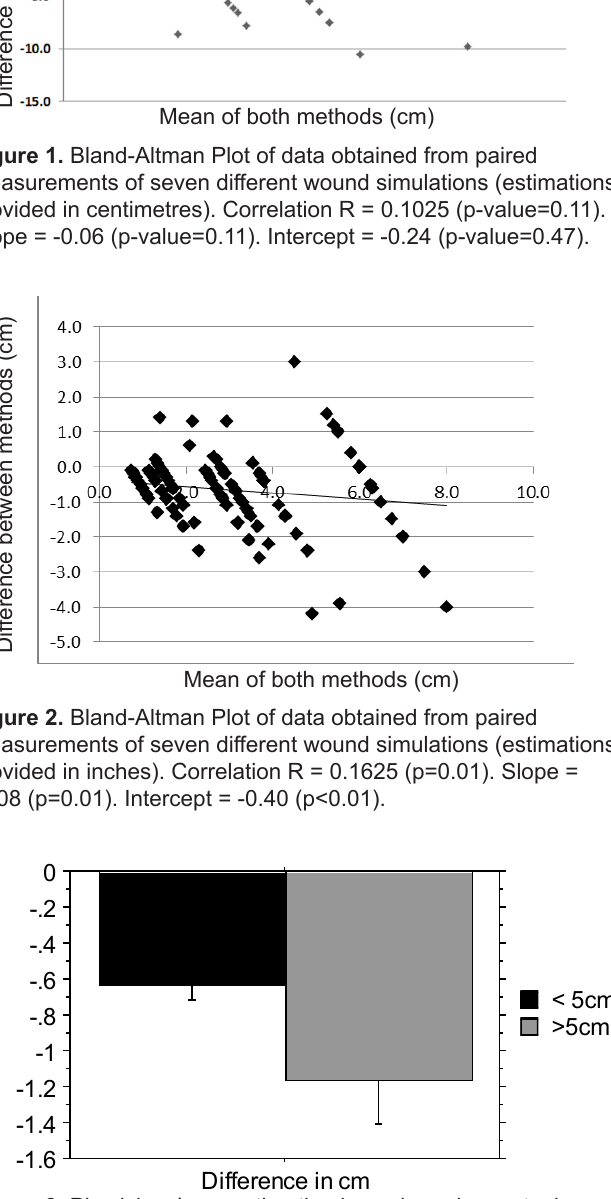
Figure 3. Physicians’ overestimation in cm based on actual wound